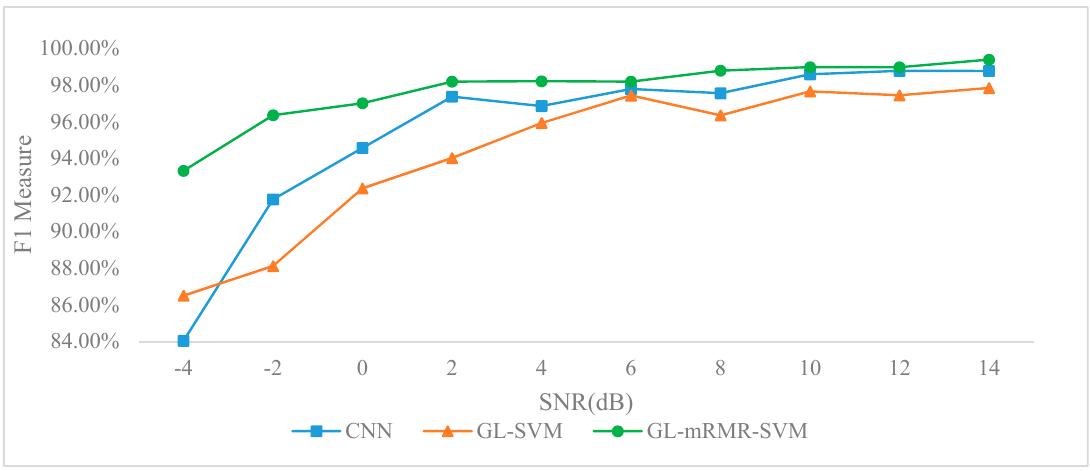
Figure 10. Diagnosis result on noisy signals with different SNRs using CNN, GL-SVM, and the proposed GL-mRMR-SVM.